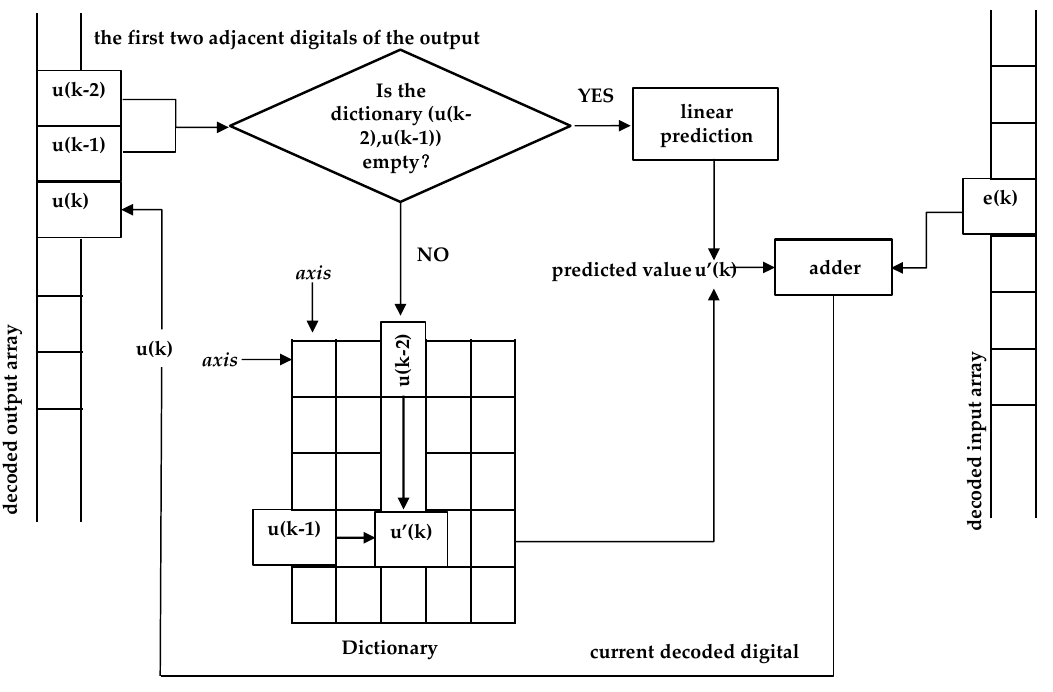
Figure 4. Principle block diagram of the decoding algorithm.